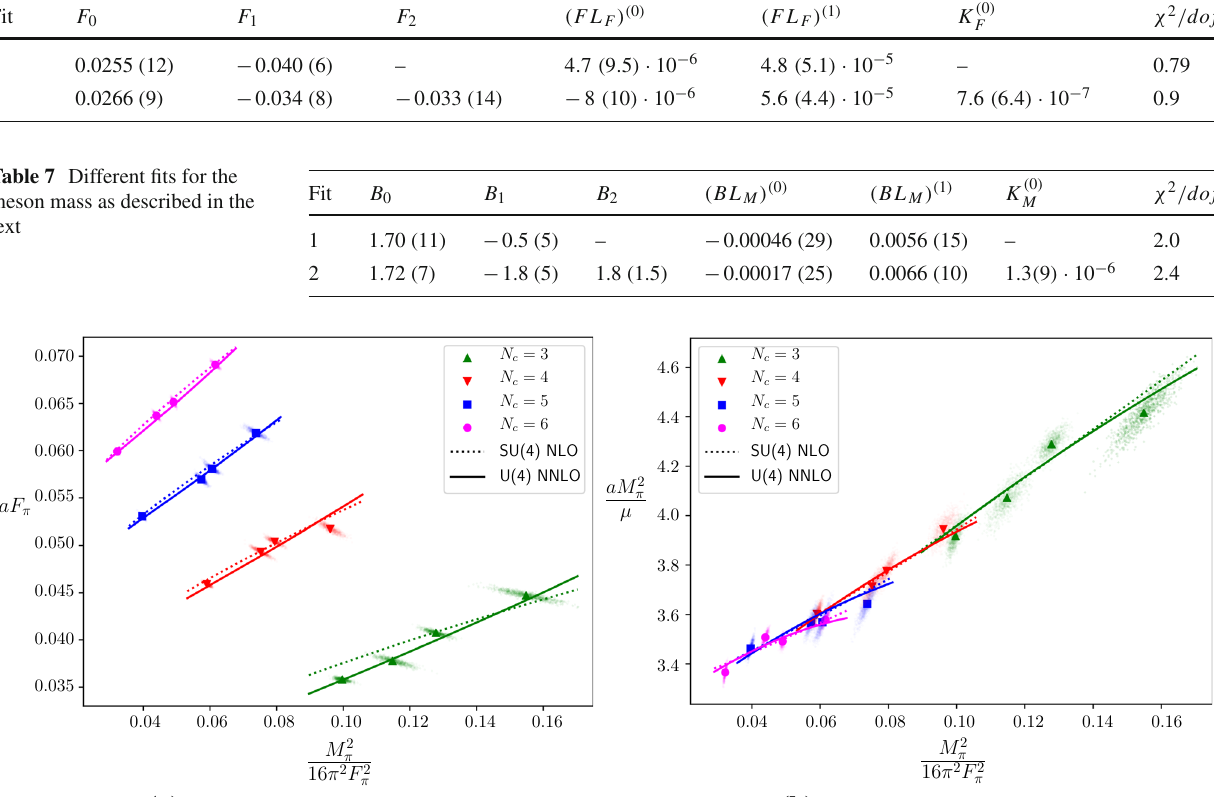
Fig. 4 Data and NLO/NNLO fits for the decay constant and meson mass. The central value is shown together with the bootstrap samples used for fitting. The results include finite-volume corrections as in Eq. (30) F